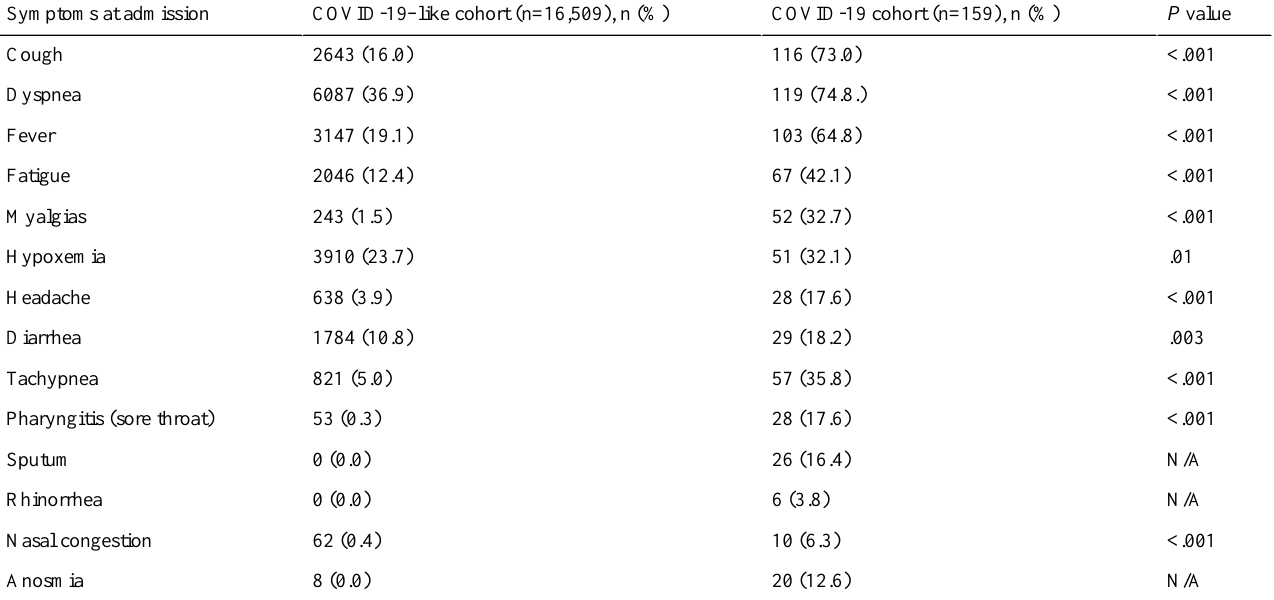
Table 2. Comparison of symptoms at admission of the COVID-19–like cohort and patients with COVID-19.